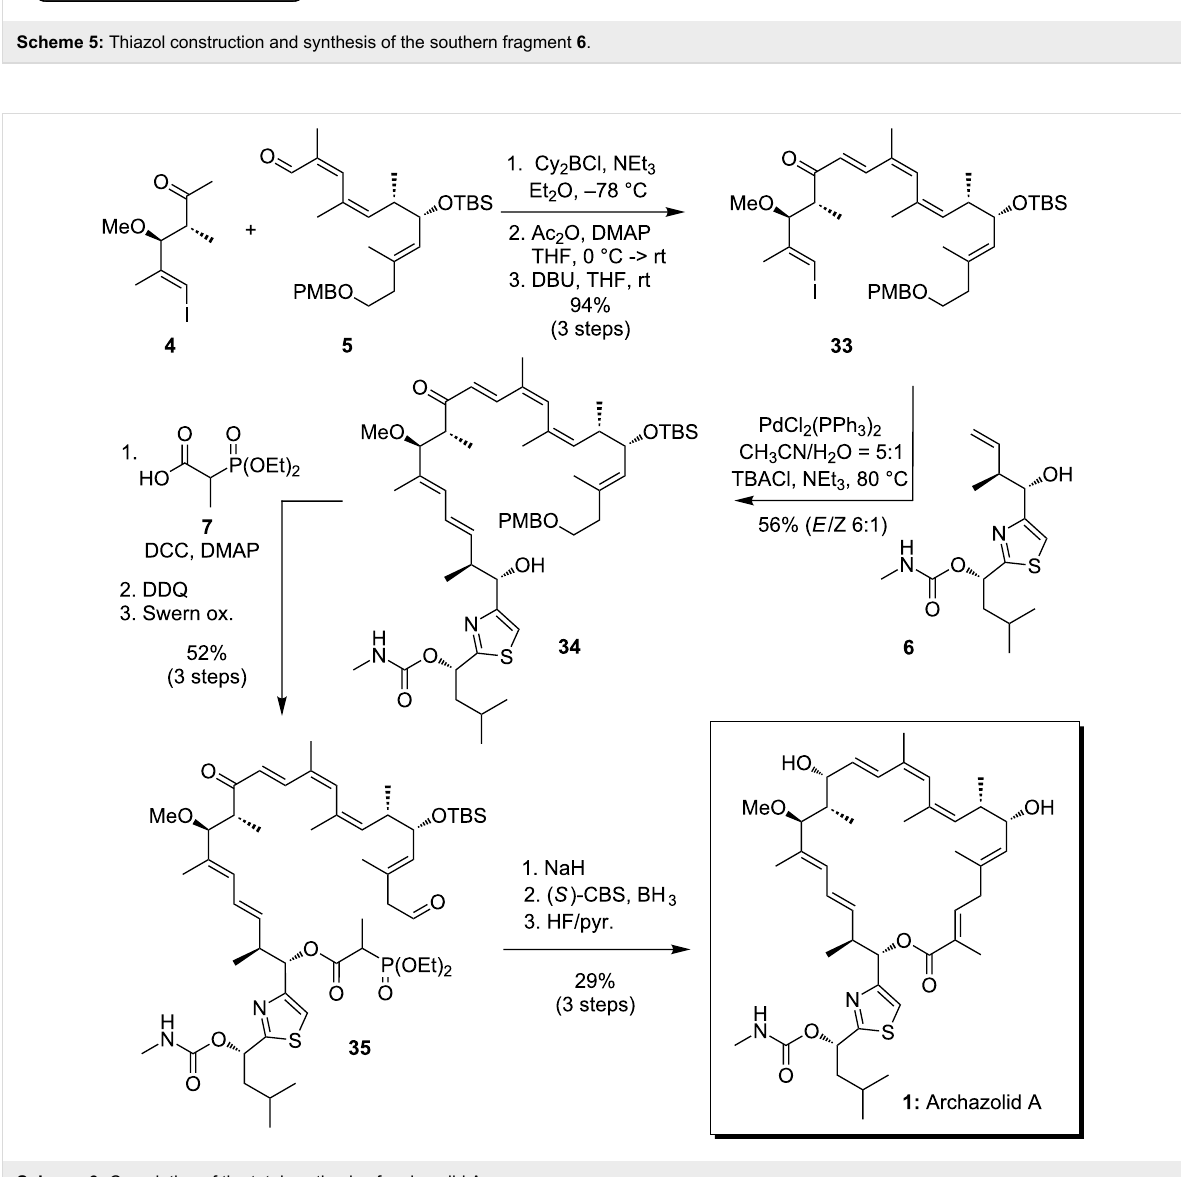
Scheme 6: Completion of the total synthesis of archazolid